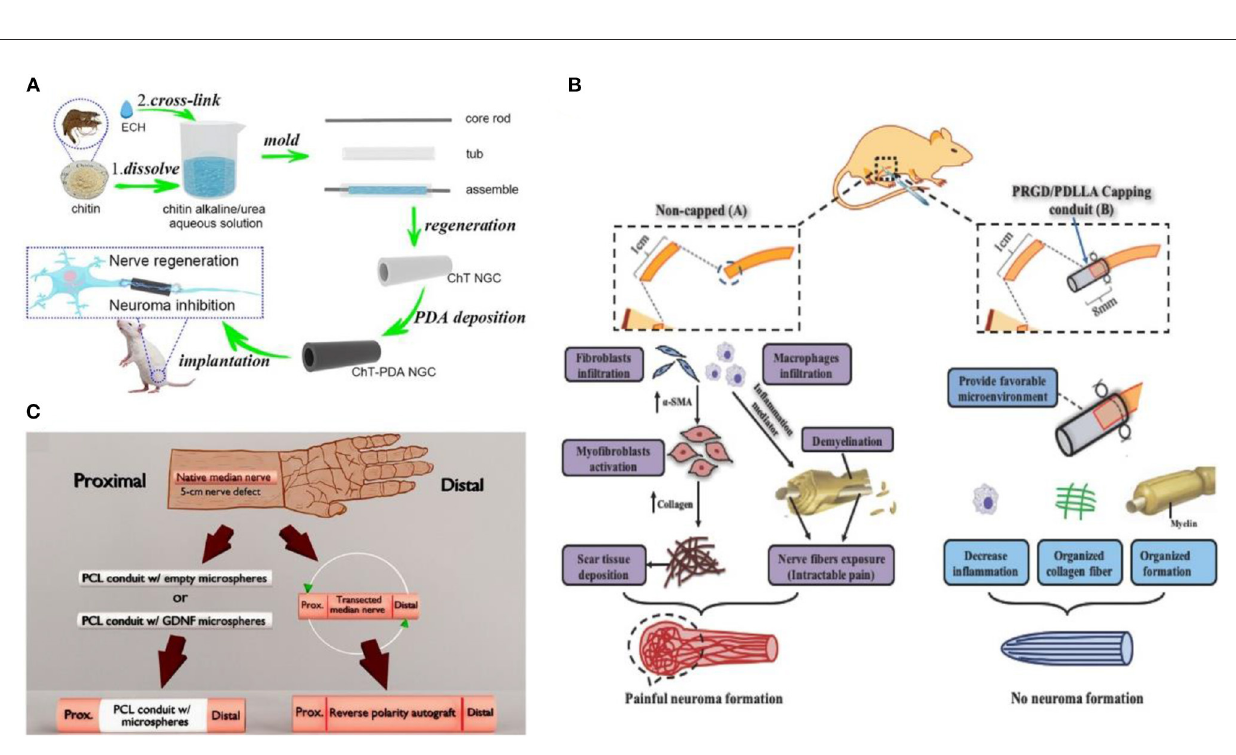
FIGURE3 (A) Schematic diagram of nerve scaffold synthesis reprinted (adapted) with permission from (27), Copyright (2022) Elsevier. (B) Schematic of PRGD/PDLLA conduit in preventing traumatic neuroma reprinted (adapted) with permission from (28), Copyright (2018) Wiley. (C) Schematic diagram of nerve cannula design reprinted (adapted) with permission from (29), Copyright (2020) The American Association for the Advancement of